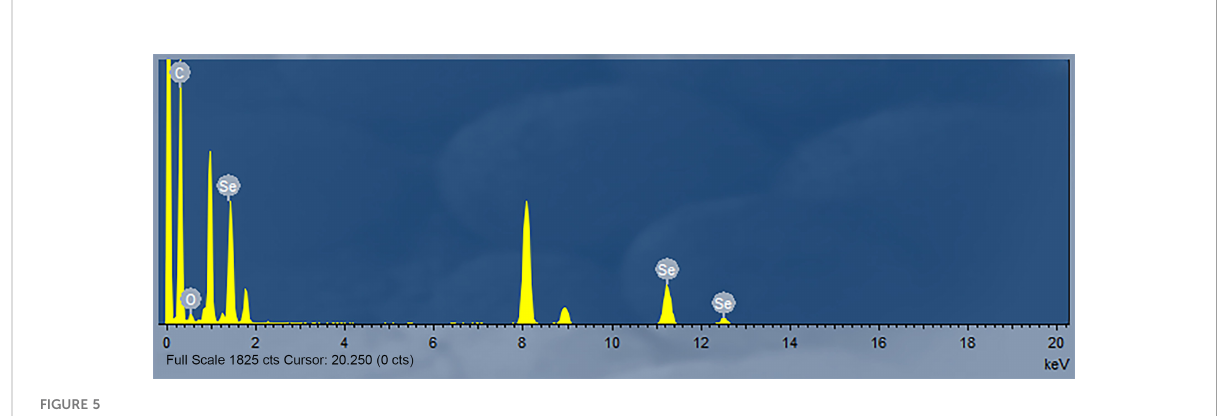
FIGURE 5 Energy Spectrum Analysis of